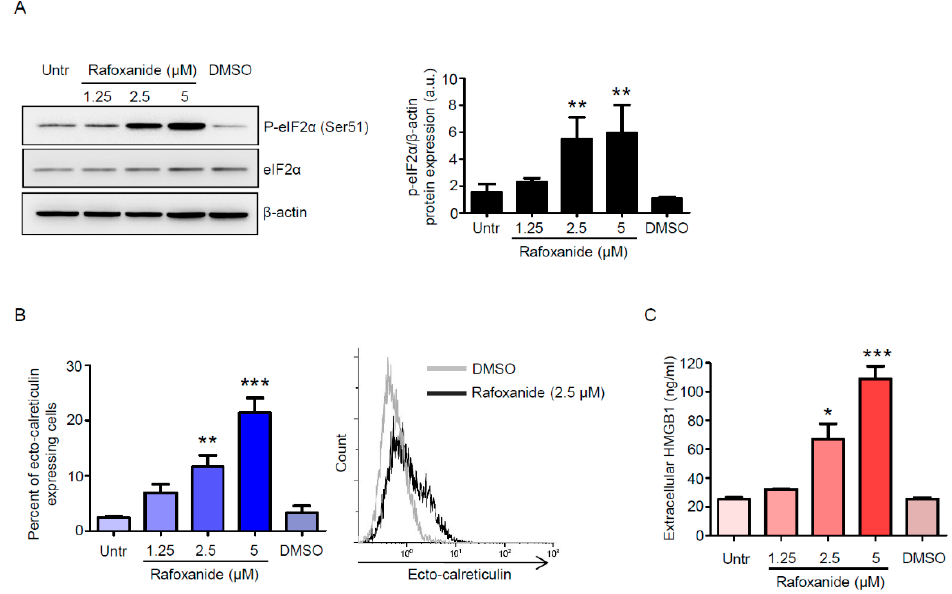
Figure 5. Rafoxanide induces immunogenic cell death markers in CT26 cells. ( A ) Representative western blotting for p-eIF2 α (Ser51) and eIF2 α in extracts of CT26 cells either left untreated (Untr) or treated with either DMSO (vehicle) or rafoxanide for 30 min. β -actin was used as loading control. The full blots are available in Figure S4 from Supplementary Materials. One of three experiments where similar results were obtained is shown. Right inset: Quantitative analysis of p-eIF2 α (Ser51) / β -actin protein ratio in total extracts of CT26 as measured by densitometry scanning of Western blots. Values are expressed in arbitrary units (a.u.) and are the mean ± SD of three experiments. Data were analyzed using one-way analysis of variance (ANOVA) followed by Dunnett’s post hoc test. DMSO vs. rafoxanide-treated cells, ** p < 0.01. ( B ) Histograms showing the percentage of ecto-calreticulin-expressing CT26 cells either left untreated (Untr) or treated with either DMSO or rafoxanide for 6 h. Results indicate the percentage of ecto-calreticulin-expressing cells as assessed by flow-cytometry analysis. Data are expressed as mean ± SD of three experiments. Data were analyzed using one-way analysis of variance (ANOVA) followed by Dunnett’s post hoc test. DMSO vs. rafoxanide-treated cells, ** p < 0.01, *** p < 0.001. Right inset. Histograms showing ecto-calreticulin in CT26 treated with either DMSO or rafoxanide as assessed by flow-cytometry. ( C ) Amount of released HMGB1 in the medium supernatant of CT26 cells either left untreated (Untr) or treated with either DMSO or rafoxanide for 48 h. Data are expressed as mean ± SD of two experiments. Data were analyzed using ANOVA followed by Dunnett’s post hoc test. DMSO vs. rafoxanide-treated cells, * p < 0.05, *** p < 0.001.